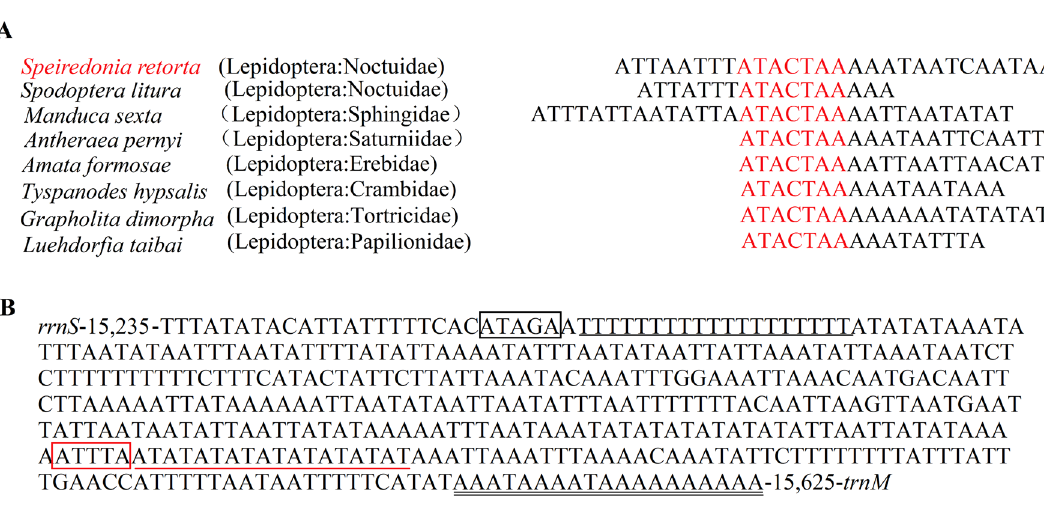
Figure 7. ( A ) The intergenic spacer region between trnS2 (UCN) and nad1 was aligned for multiple Lepidopteran species, with the conserved ‘ATA CTA A’ motif being highlighted. ( B ) Features of the S. retorta A + T-rich region are shown in the reverse strand, with the ATA TGA motif being highlighted. Double underlines were used to mark the poly-A region, while a single underline was used to mark the poly-T region. A dotted underline was used to mark single microsatellite T/A